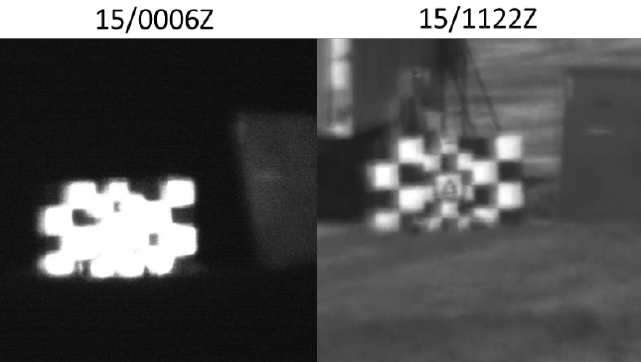
Figure 12. DELTA camera images as recorded at the times shown on 15 July 2021. Spurious banding effects are evident on the left edges of the leftmost white target board patches in the 1122UTC image.